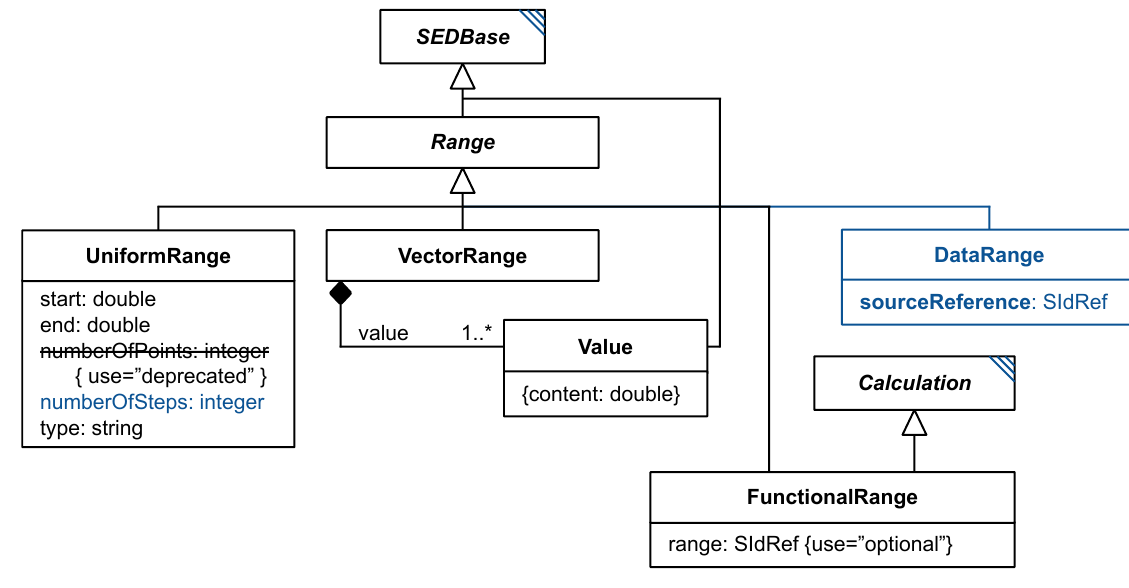
Figure 2.14: The SED-ML Range